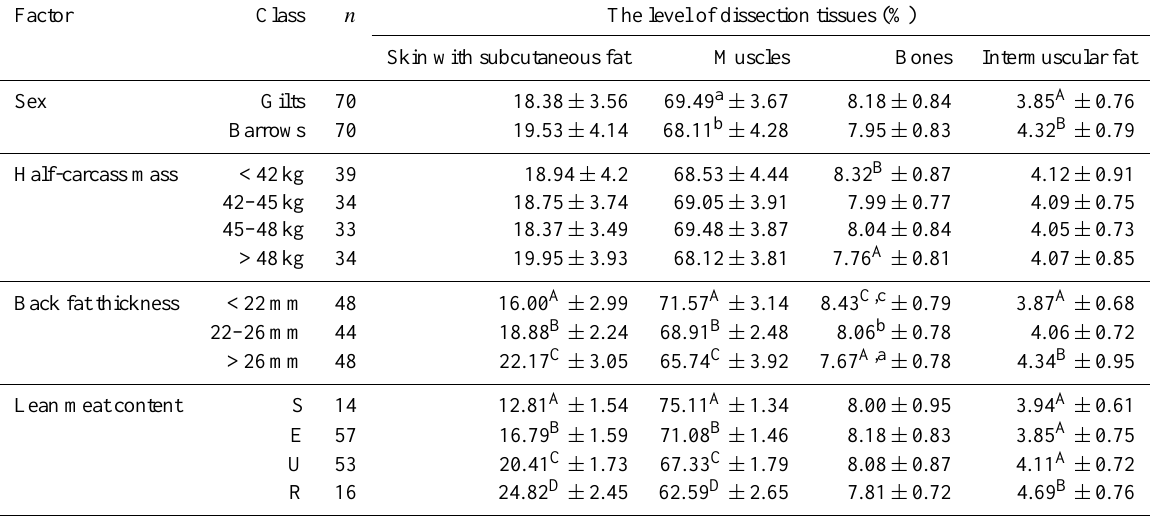
Table 2. The percentage level of ham dissection tissues, according to factors tested. Factor Class n The level of dissection tissues (%) Skin with subcutaneous fat Muscles Bones Intermuscular fat Sex Gilts